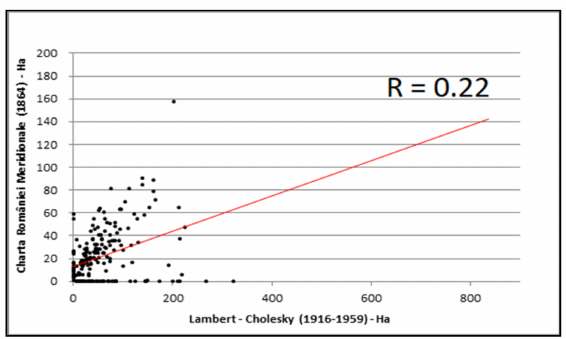
Figure 5. The progressive tendency specific to settlement areas in Central B ă r ă gan Plain. Areas which suffered the smallest transformations correspond to forested